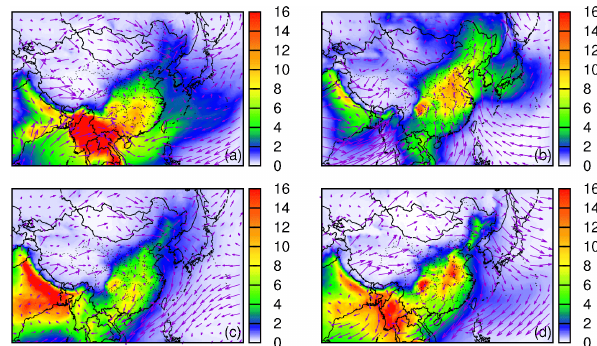
Figure 4. Predicted monthly average SOA concentrations in (a) spring (March, April and May), (b) summer (June, July and Au- gust), (c) fall (September, October and November), and (d) winter (December, January and February) 2013. Units areµgm − 3 . Over- lain on the panels are seasonal average wind